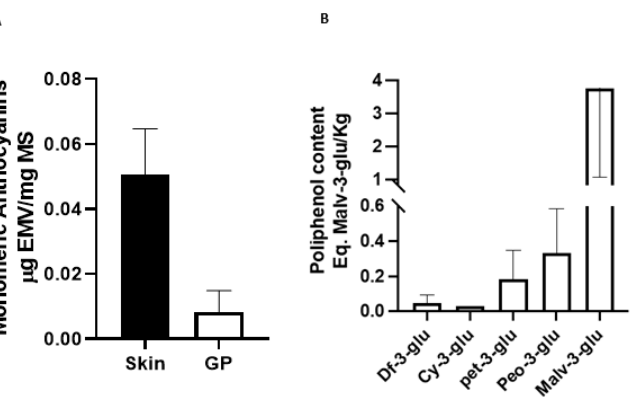
Figure 1. Total anthocyanin content (Eq. Malv-3glu/Kg) of two samples from both HPLC systems ( A ) and the pH differential method ( B ).